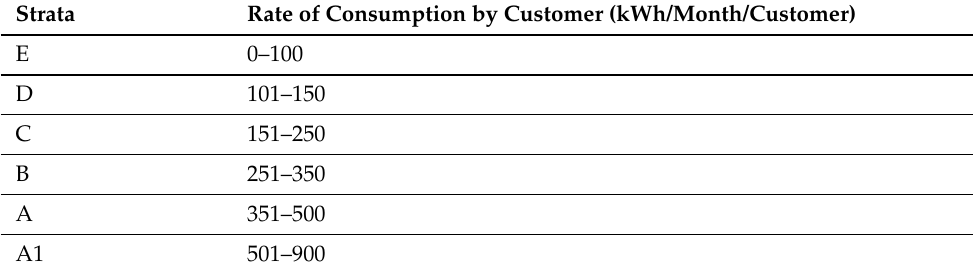
Table 2. Strata of electricity